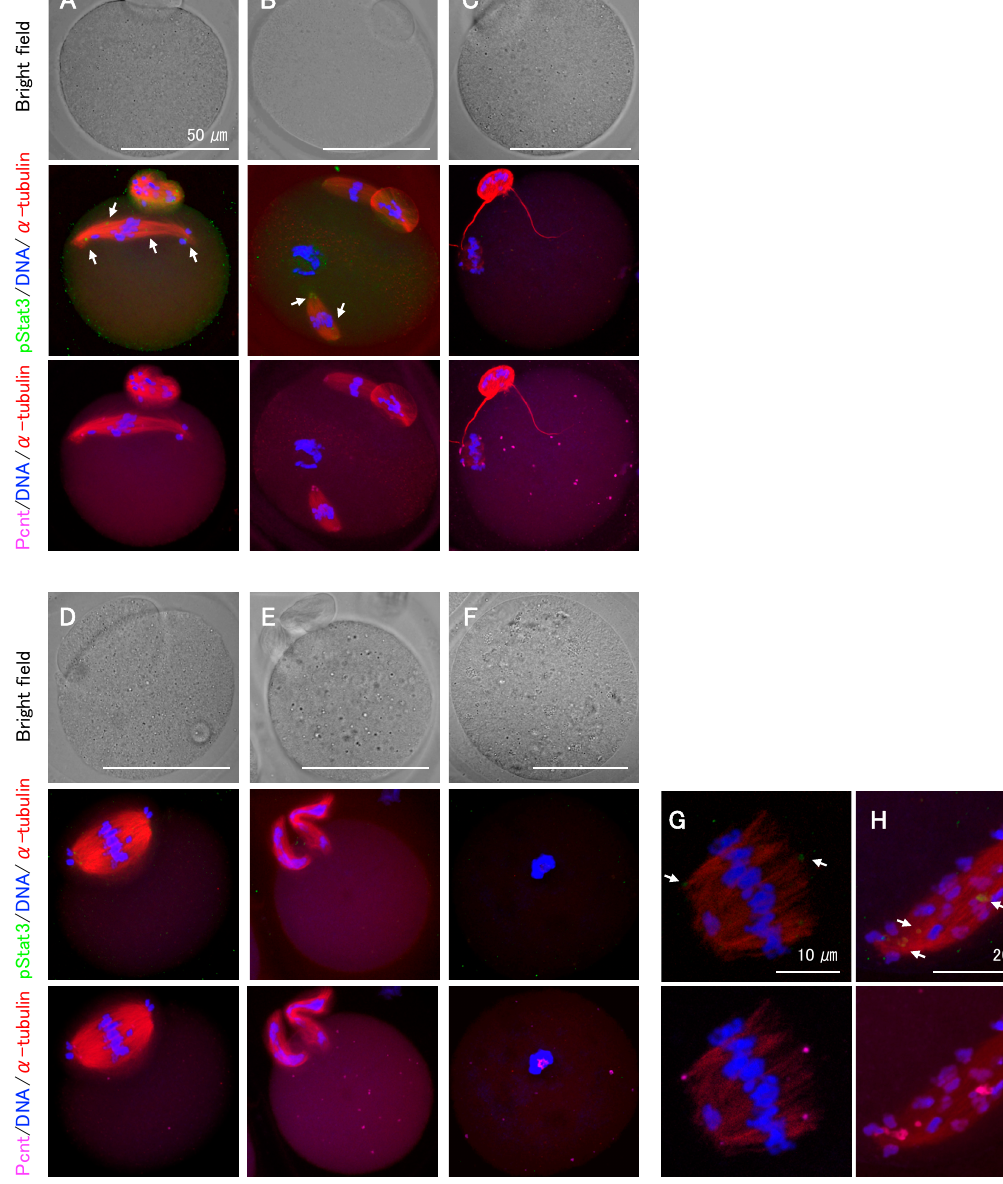
Figure 4. Representative features of abnormal MII oocytes treated with either Stat3 inhibitors or anti-pStat3 antibody. ( A – C ) These oocytes appear normal under bright field microscopy. ( A ) The spindle elongation and chromosomes aberration. ( B ) Two spindles involving chromosomes. A chromosome aggregation without spindle body is also seen. ( C ) Shortened and improper spindle formation. String-shaped microtubules are observed to extend from the polar body. ( D ) A larger polar body with expanded spindle assembly. ( E ) Two polar bodies with no spindle formation. ( F ) No polar body and spindle formation. Condensed chromosome with pericentrin is observed. ( G , H ) Higher magnification of abnormal spindles and chromosome mis-location. Note that the expression of pStat3 is either very faint and at an incorrect location (allows shown in A , B , G , H ) or negative ( C , D , E , F ). Different colors indicate pStat3 (green), α -tublin (red), pericentrin (Pcnt) (magenta), and DNA (blue).